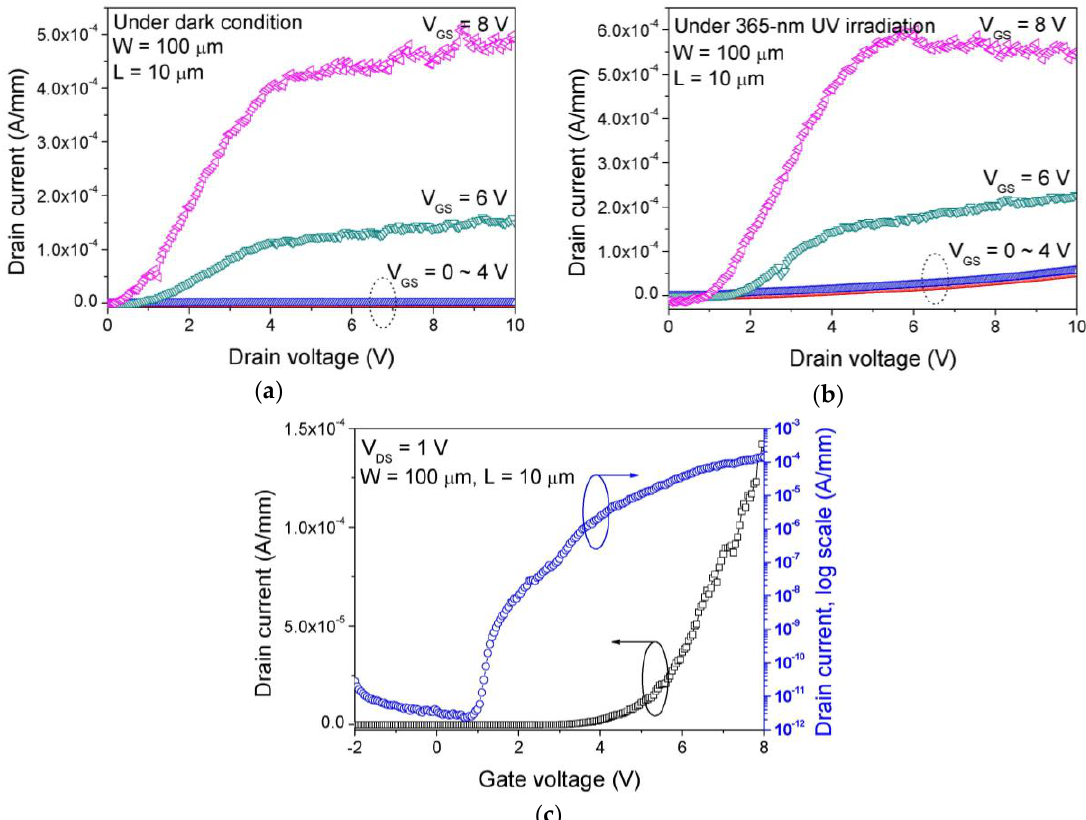
Figure 4. ( a ) Output I DS –V DS characteristic under dark, ( b ) output I DS –V DS characteristic under 365-nm UV irradiation, and ( c ) linear and log-scale transfer I DS –V GS characteristics of the fabricated GaN Schottky-barrier (SB)-metal-oxide-semiconductor field-effect transistor (MOSFET).